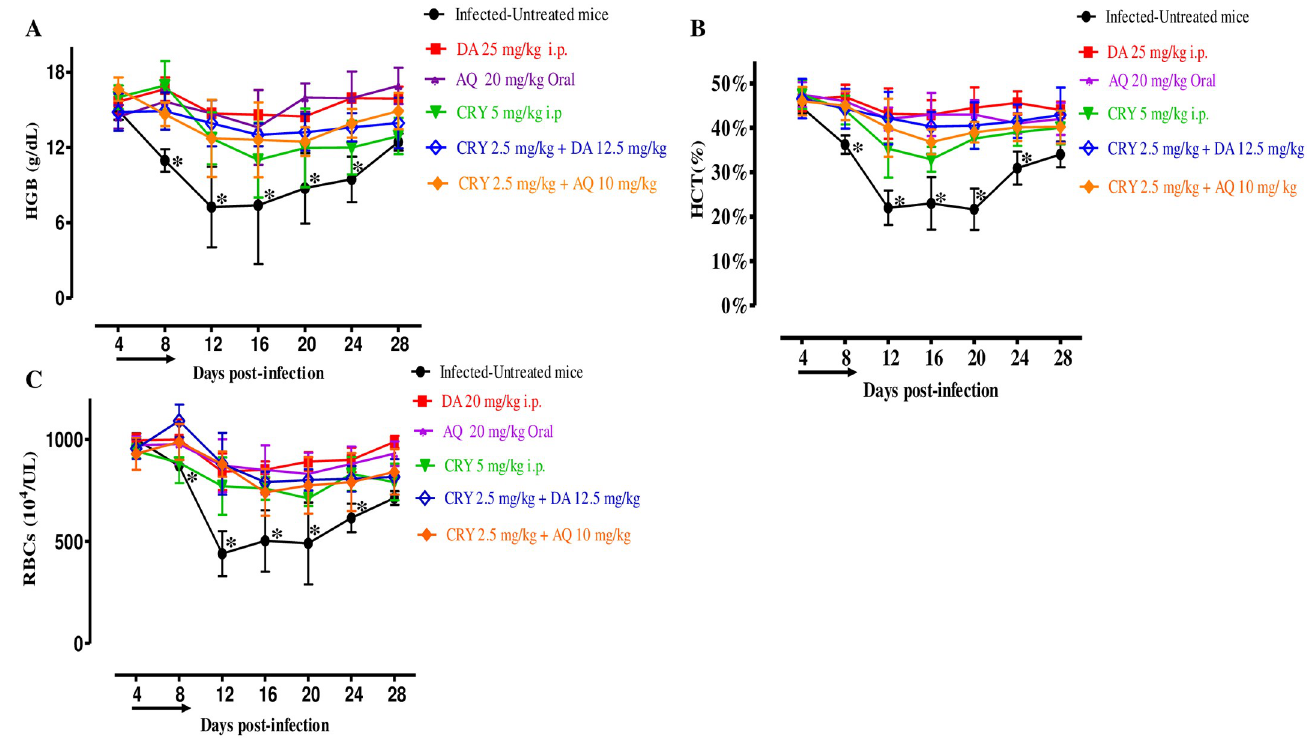
Fig 4. Hematology profiles of CRY-treated mice in vivo . Graphs showing the changes in the HGB (A), HCT (B), and RBCs (C) of treated mice as compared with untreated mice. The values plotted are the mean ± standard deviation for two separate trials. Asterisks ( � ) indicate statistical significance ( P < 0.05) based on the unpaired t -test analysis. The arrow indicates 5 consecutive days of